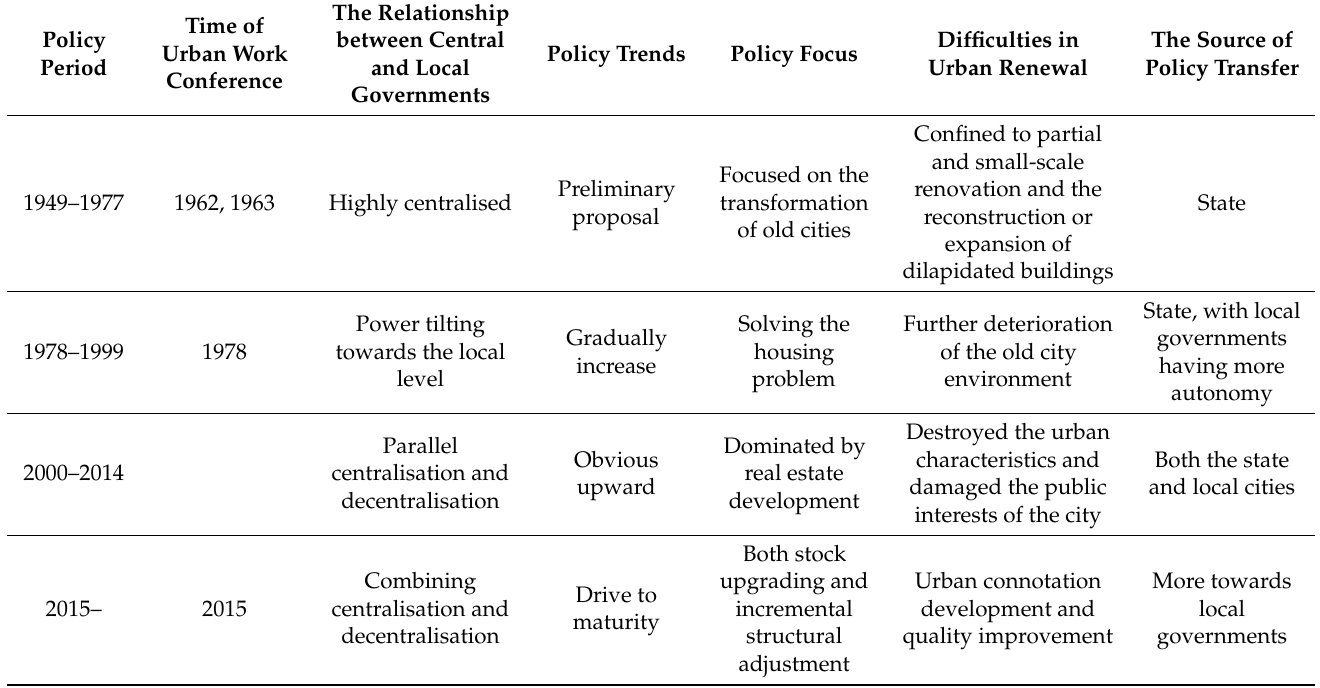
Table 1. Analytical framework of urban renewal policy paradigm in